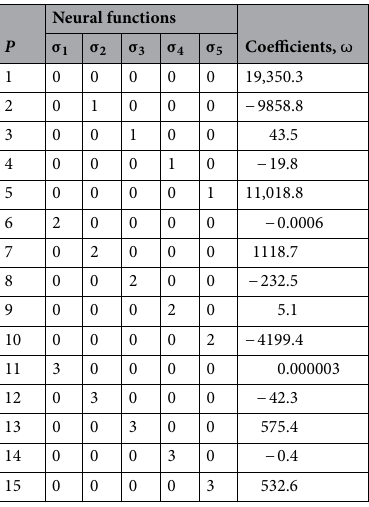
Table 4. Neural functions and respective coefficients.